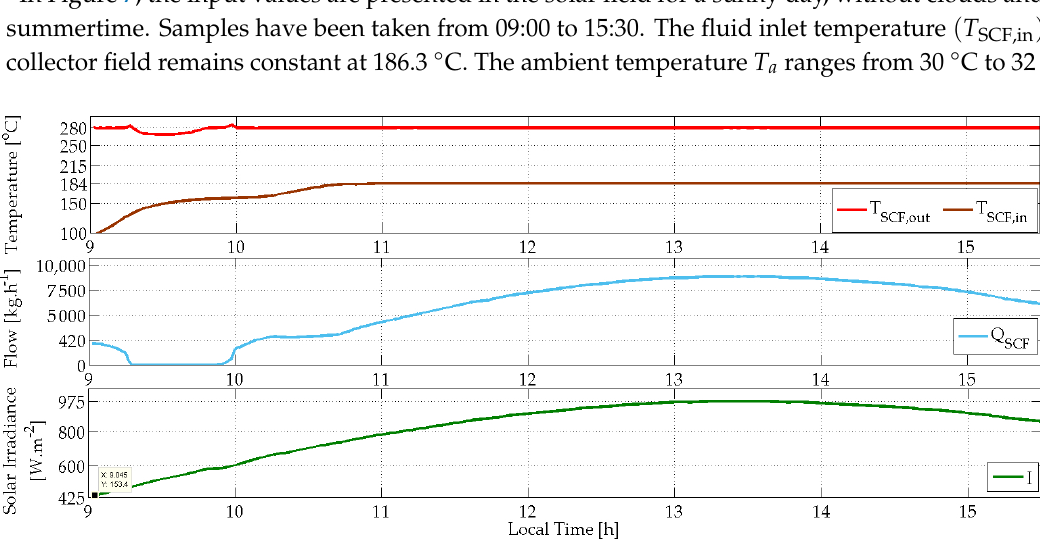
Figure 7. Results of the parabolic collector